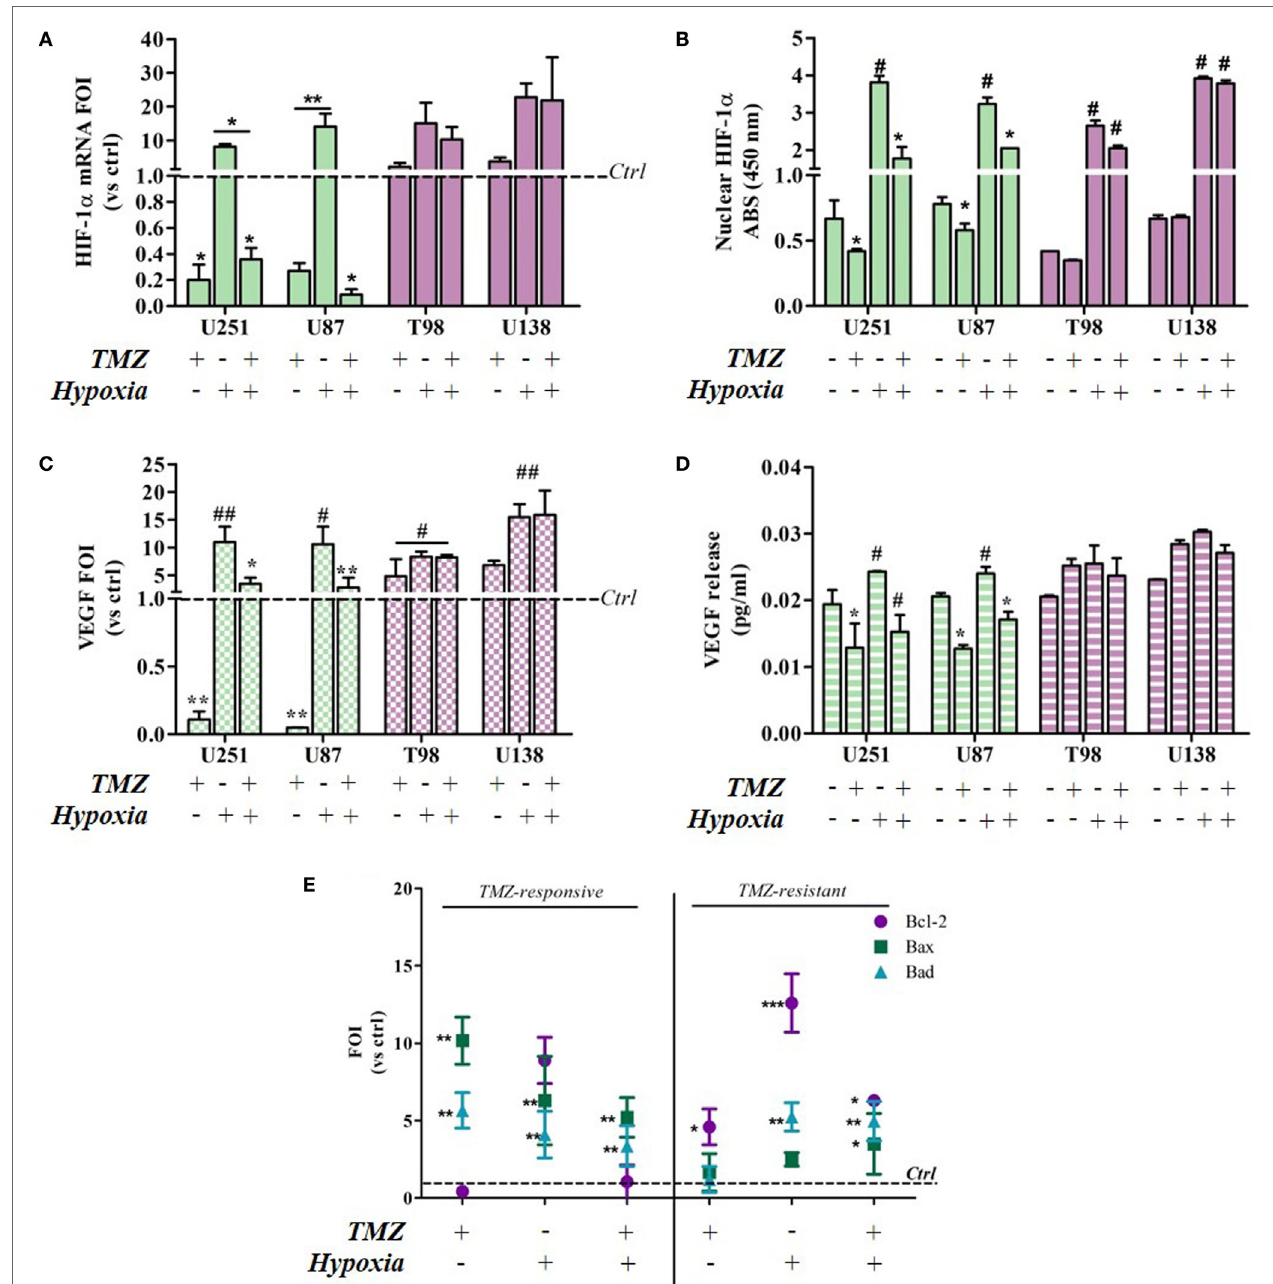
FigUre 2 | Temozolomide (TMZ) modulation of hypoxia-inducible factor (HIF)-1 α expression and activity and apoptotic gene expression profiles in TMZ-sensitive and TMZ-resistant glioblastoma cells. (a) HIF-1 α expression revealed by real-time PCR after 24 h treatment with TMZ 100 µM under normoxic and hypoxic conditions. The data were normalized to β -actin, and the ΔΔ Ct values were expressed as folds of induction (FOI). * p < 0.05; ** p < 0.01 treated vs untreated cells. (B) ELISA-based HIF-1 α nuclear quantification after TMZ treatment under normoxic and hypoxic conditions. The data are expressed as absorbance at 450 nm. * p < 0.05 vs control under normoxic conditions; # p < 0.05 vs control under hypoxic conditions. (c) Vascular endothelial growth factor (VEGF) expression revealed by real-time PCR after treatment with TMZ 100 µM under normoxic and hypoxic conditions. The data were normalized as above. * p < 0.05; ** p < 0.01 TMZ-treated vs control cells under normoxic conditions; # p < 0.05, ## p < 0.01 TMZ-treated vs control cells under hypoxic conditions. (D) ELISA of the VEGF released by glioma cells in cell medium after TMZ treatment. * p < 0.05 TMZ-treated vs control cells under normoxic conditions; # p < 0.05 TMZ-treated vs control cells under hypoxic conditions. (e) The induction of pro-apoptotic ( Bad and Bax ) and anti-apoptotic genes ( Bcl-2 ) was analyzed by means of real-time PCR in glioma cells treated with TMZ under normoxic and hypoxic conditions. The data were normalized to β -actin, and the ΔΔ Ct values were expressed as the ratio between the mean values in the responsive and resistant cells (FOI). * p < 0.05; ** p < 0.01; *** p < 0.001 treated vs control cells. Mean values ± SD of three independent experiments.